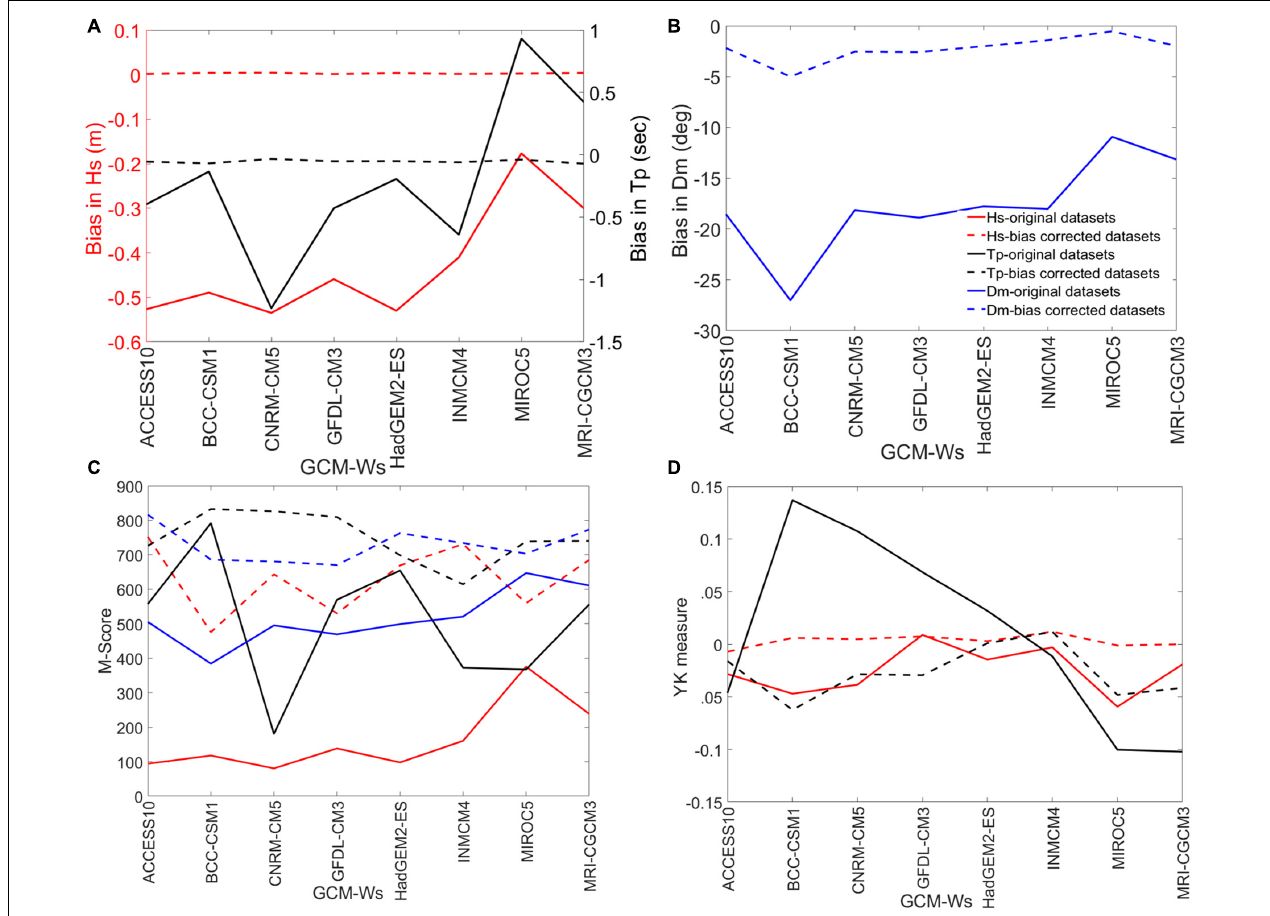
FIGURE 6 | Comparison of the bias corrected and the original datasets in terms of (A) Biases in H s and T p ; (B) Biases in D m ; (C) M-Scores; (D) YK